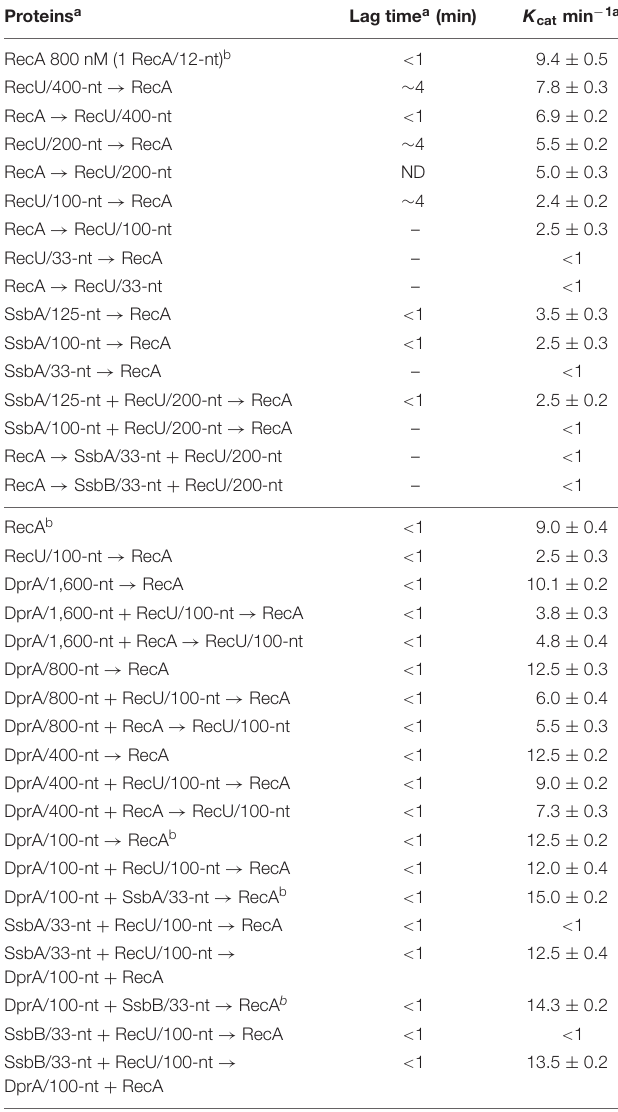
TABLE 2 | Rates of ssDNA-dependent ATP hydrolysis and lag time measurements. Proteins a Lag time a